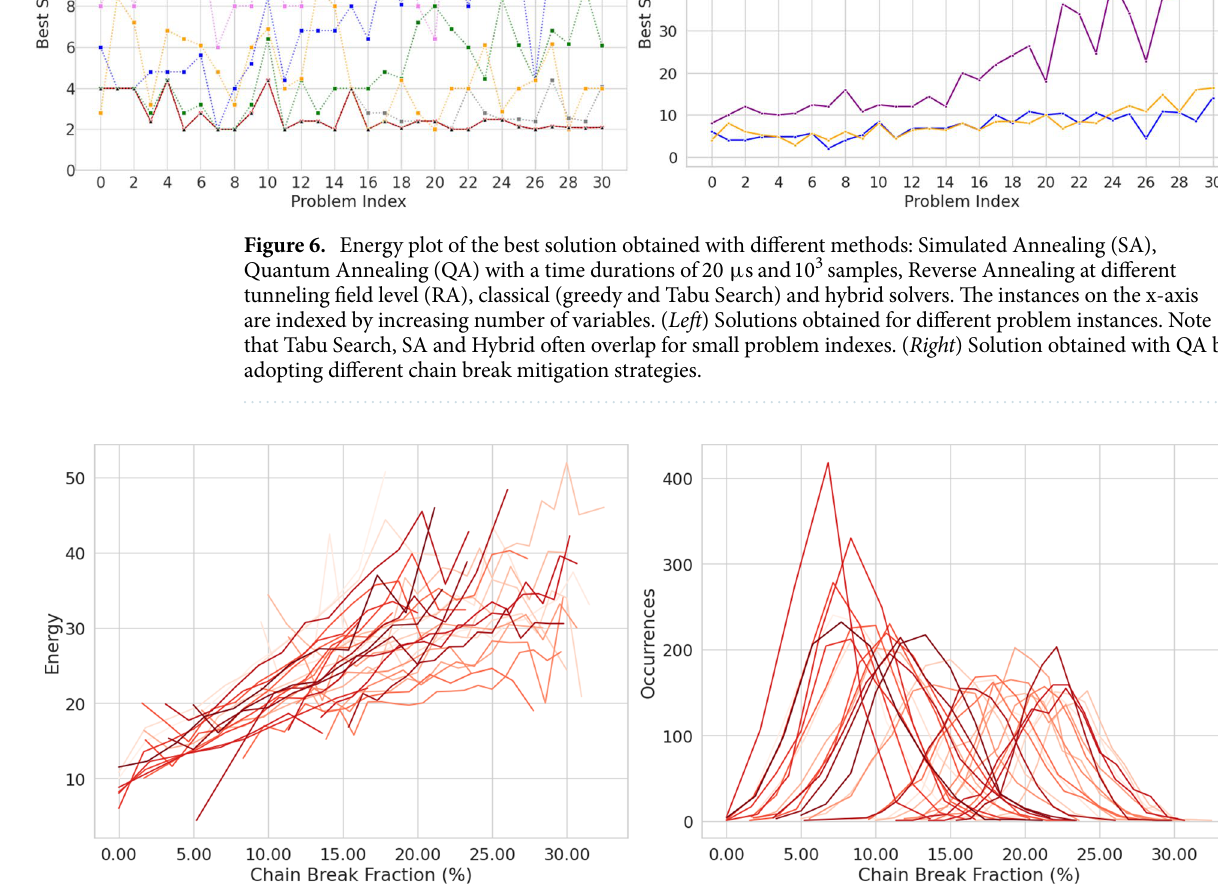
Figure 7. Chain break analysis of the 31 problems with unknown solutions, each problem is represented with a 3 different red-yellow shade. ( Left ) Mean of the best solution energy of the 10 samples of QA for each problem for a selected chain break fraction. ( Right ) Distribution of the chain break fraction in each problem, the occurrence counts the number of sampled solutions that shows a given Chains and chain breaks. As shown in “Square instances with a known optimal solution” section, the number of qubits necessary to embed the JSSP instances on a QPU differs considerably from the number of variables of the QUBO model. The embedding procedure maps each variable to one or more qubits, by forming chains. The length and the number of chains depend on the specific QPU topology, thus the same problem instance has dif- ferent chain distributions for different QPUs. The right panel of Fig. 7 shows, for each instance, the distribution of the chain break fraction and we observe a typical Gaussian profile, with a considerable high mean (always greater than 5% and averaging around 15% , among all instances) and a consistent standard deviation. The left panel shows the relationship between the mean chain break fraction and the mean energy of the solutions; there is a visible and almost linear correlation indicating that as the chain break fraction increases the solution quality worsens. The chain break fraction can be mitigated by adjusting the chain strength when the minor embedding is performed. The default chain strength is 2, but other heuristic strategies can be adopted. Scaled , in which the chain strength is scaled to the problem bias range, returns a chain strength = 8 ; uniform torque compensation , which attempts to compensate for random torque of neighboring qubits that would break the chain, results in a chain strength in the range of 15–22; max energy delta , which is based on the maximum increase in energy that is due to flipping a single variable and the obtained chain strength varies in the range 42–90.